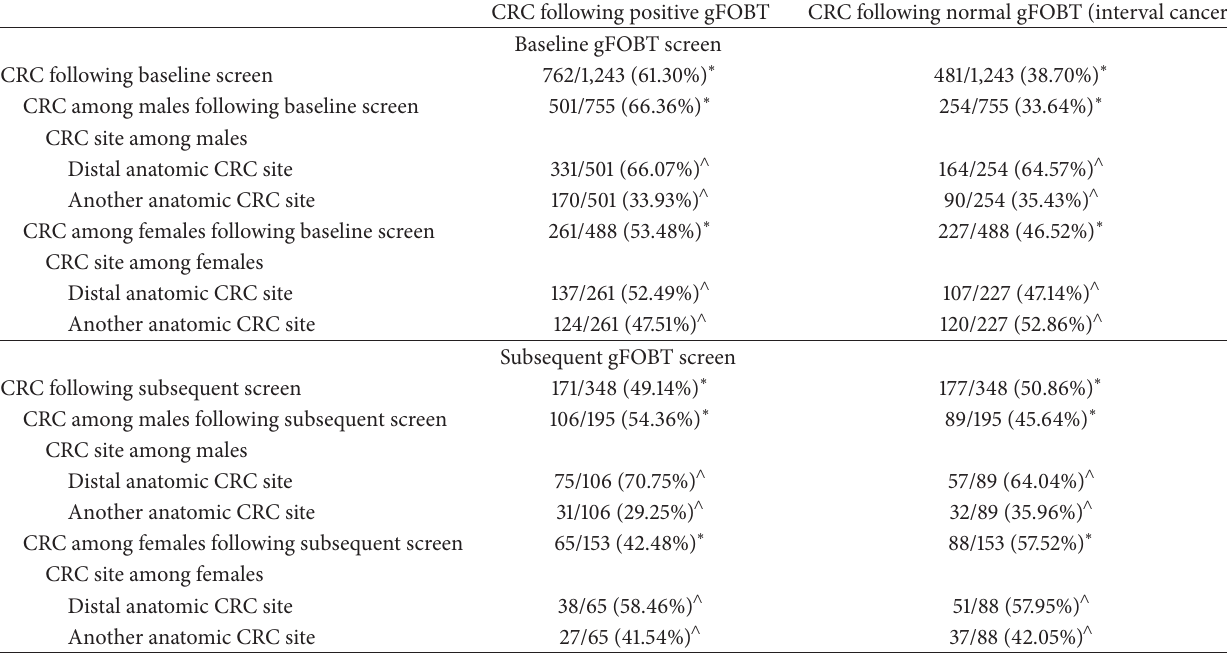
Table 3: CRC diagnosed within 24 months following gFOBT by baseline and subsequent screen, gFOBT result, sex, and anatomic CRC